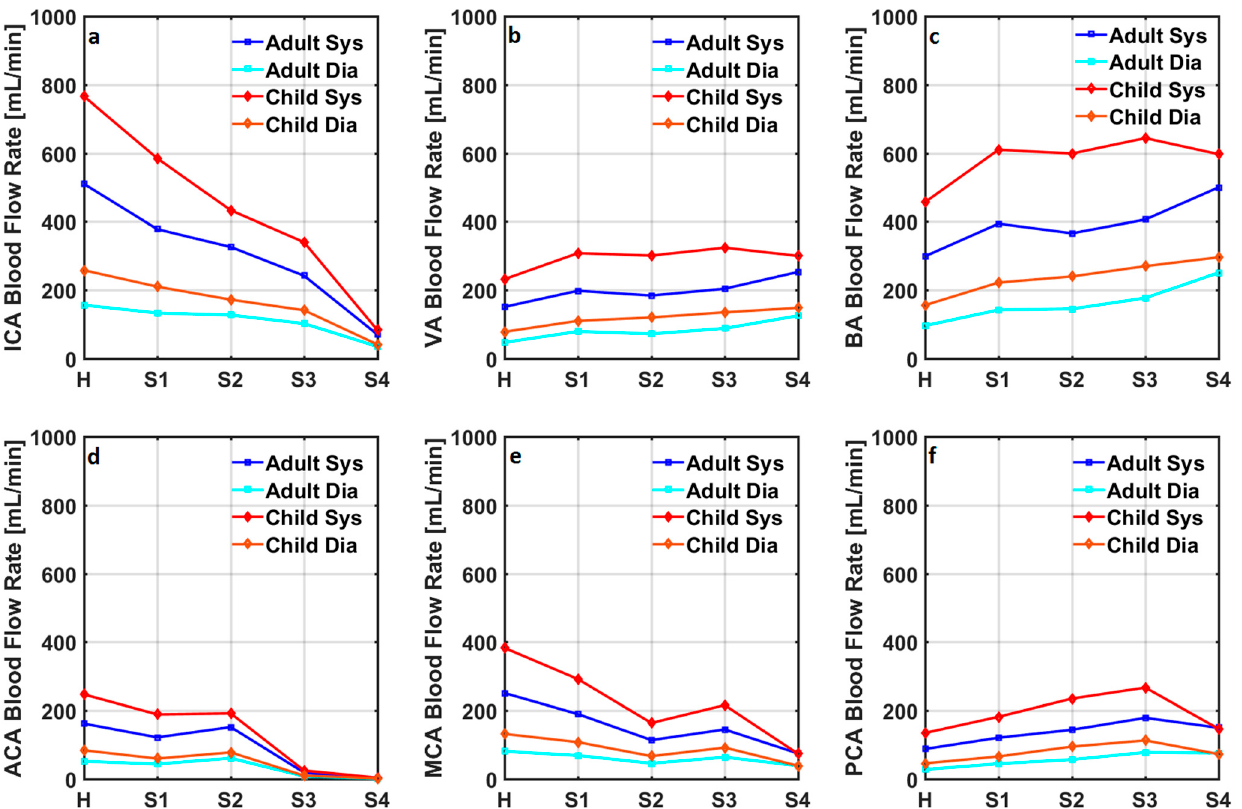
Figure 5. Systolic and diastolic cerebral blood flow rates in ( a ) internal carotid arteries (ICA), ( b ) vertebral arteries (VA), ( c ) basilar artery (BA), ( d ) anterior cerebral arteries (ACA), ( e ) middle cerebral arteries (MCA), and ( f ) posterior cerebral arteries (PCA) in the adult and child cardiovascular system models simulating a healthy condition and advancing stages of the Moyamoya disease. H, S, Sys, and Dia represent healthy, stage, systolic, and